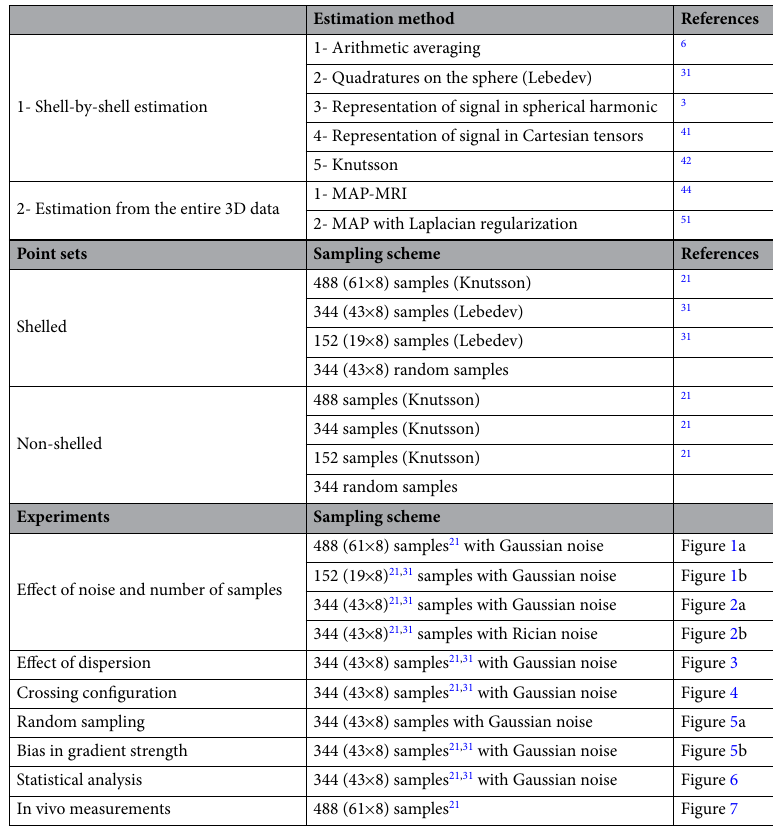
Table 1. The summary of powder-averaging techniques, different vector sets and different experiments conducted in this